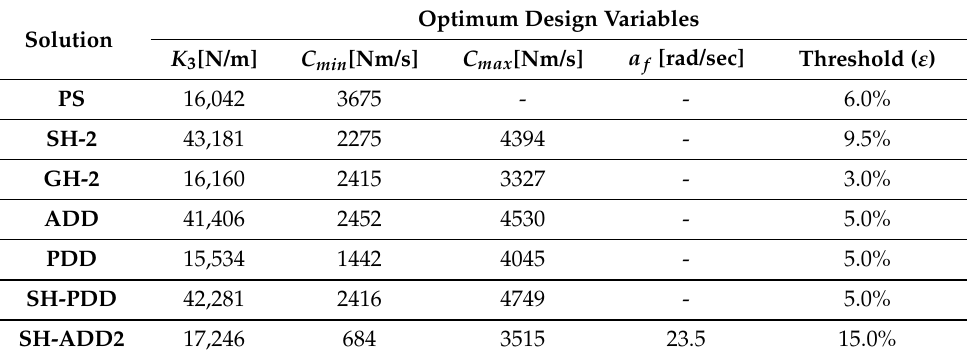
Table 6. Common optimal suspension parameters among the two road profile cases for each suspen- sion